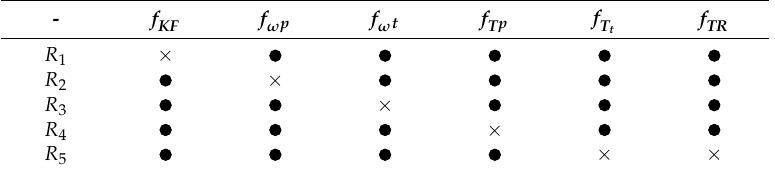
Figure 11. Responses of the five residuals: ( a ) when fault 𝑓 (cid:3012)(cid:3007) happens; ( b ) when fault 𝑓 (cid:3104)